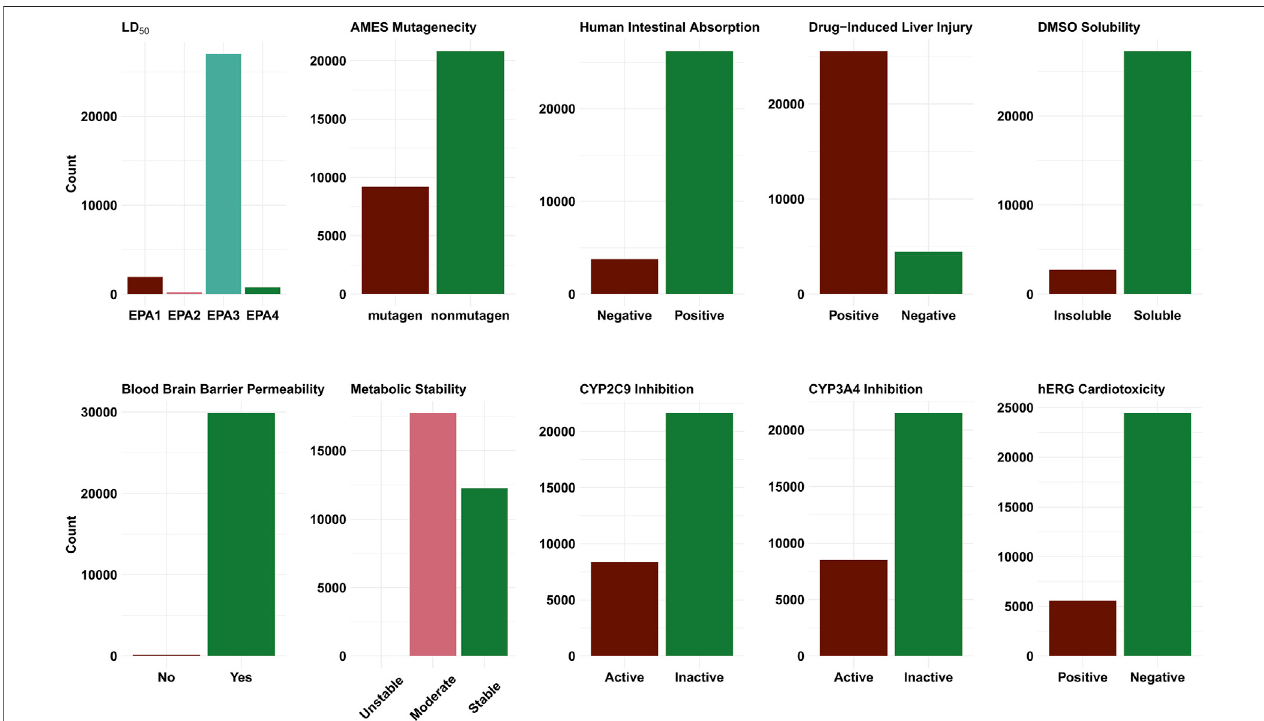
FIGURE4| Barplotsshowingthedistributionofthepredicted classesforthe differentADMET endpoints. EPA1 corresponds tothe(LD 50 ≤ 50 mg/kg) thehighest toxicity category. EPA2 (moderately toxic) includes chemicals with 50 < LD 50 ≤ 500 mg/kg. EPA3 (slightly toxic) includes chemicals with 500 < LD 50 ≤ 5,000 mg/kg. Safe chemicals (LD 50 > 5,000 mg/kg) are included in EPA4. Here, the color green is used to indicate compounds that are better suited for further study.